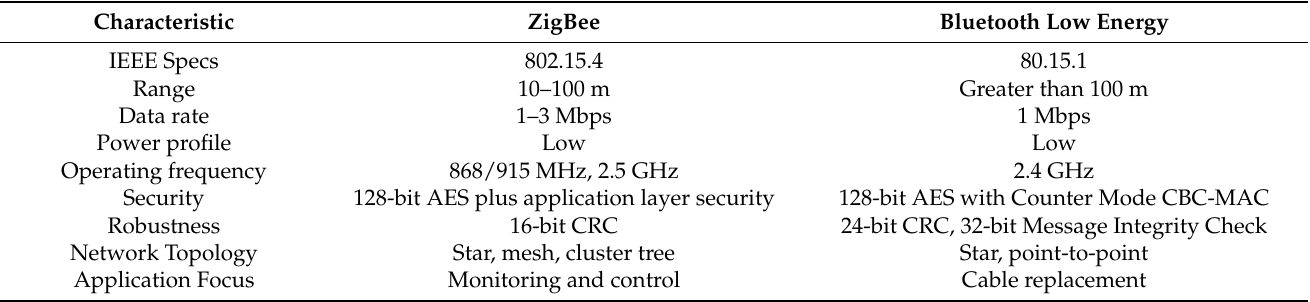
Table 1. Comparison between ZigBee and Bluetooth Low Energy (v4.2)